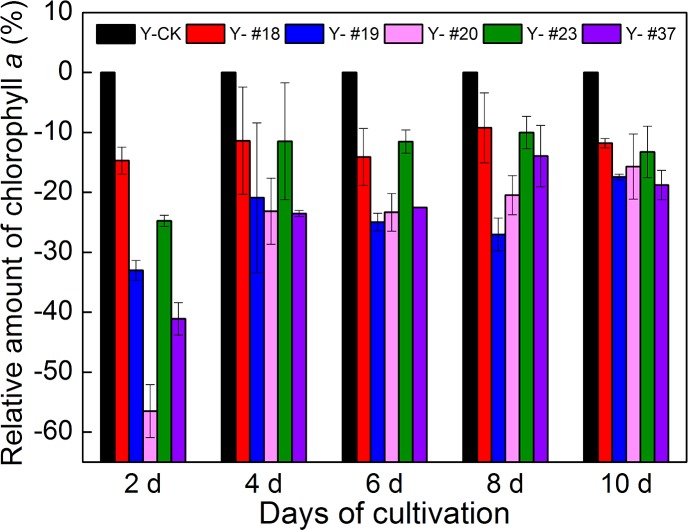
Screening of Selenastrum capricornutum progenies based on the relative content of Chl a.The amount of Chl a in each progeny was compared with the amount present in the control group(Y-CK) at each time point. The initial inoculation amount of each progeny and of the control group was 6.25% by volume. OD 680 nm of the progenies and of the control group (0 d) was measured, and the Chl a measurement was not influenced by the growth rates. The error bars indicate the SD of six biological replicates from two independent screenings.